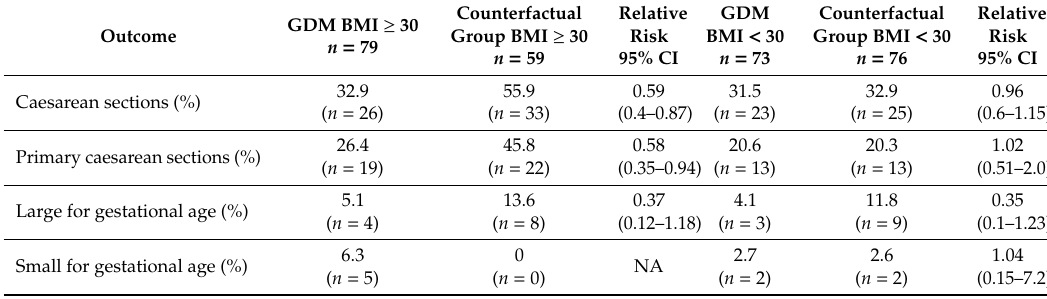
Table 4. Risk of maternal and neonatal outcomes in women treated for GDM compared to the untreated counterfactual group, stratified by